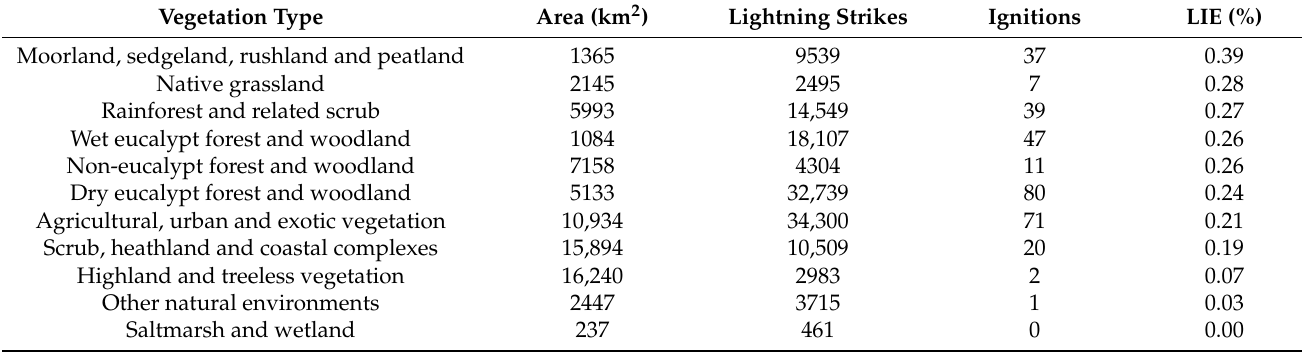
Table 3. Ignition efficiency by cloud-to-ground (CG) lightning strikes as a function of different vegetation types across Tasmania